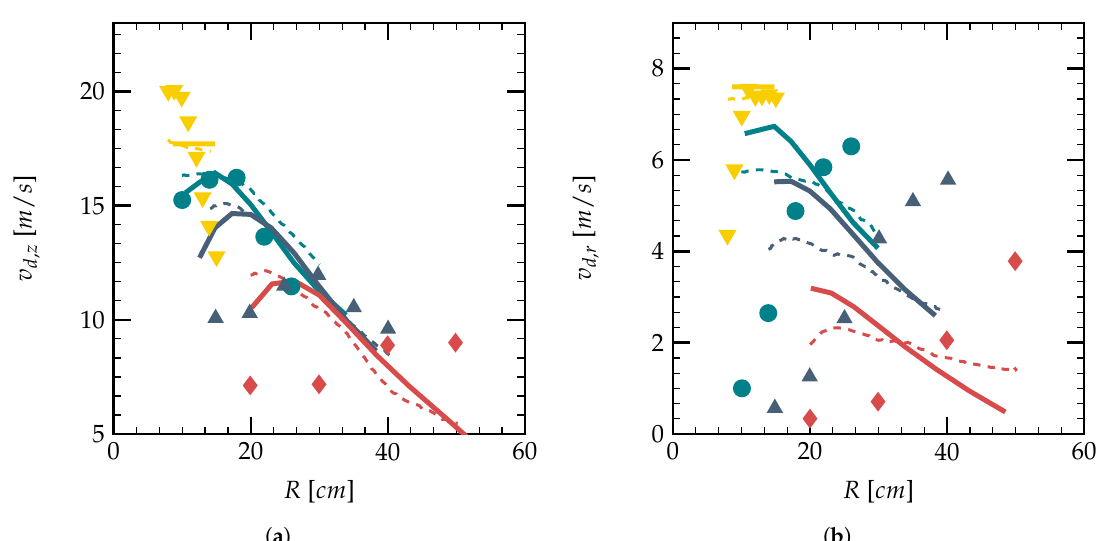
Figure 6. Validation of the droplet velocity at different vertical positions as a function of the radial distance from the center R for a monodisperse spray; ( a ) axial velocity v d , z and ( b ) radial velocity v d , r . Experimental measurements at h = 20 cm, ( ), h = 40 cm ( ), h = 60 cm ( ), h = 95 cm ( ); numerical simulation of [21] at h = 20 cm ( ), h = 40 cm ( ), h = 60